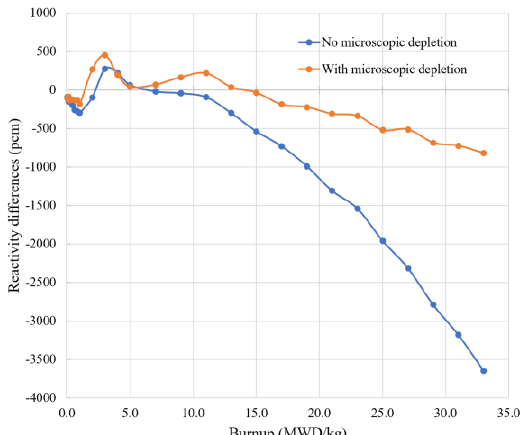
Figure 3. Benchmark 3D-Assembly Level of PANTHER vs